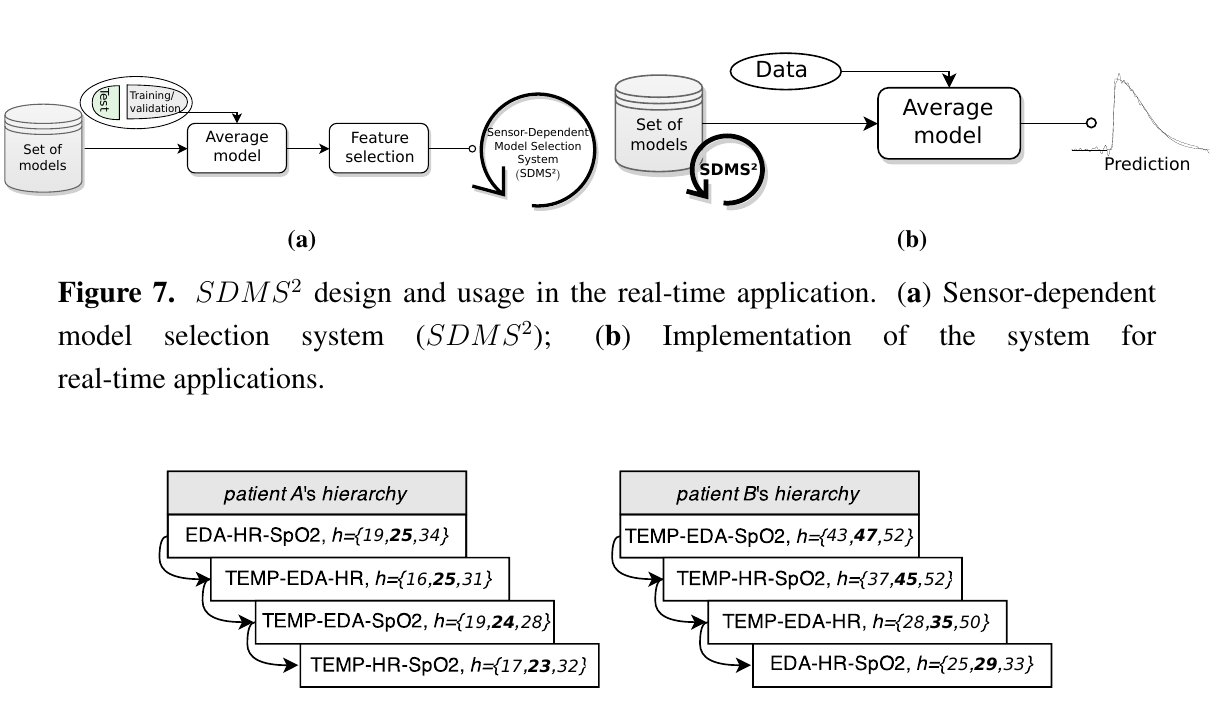
Figure 8. Hierarchies of sets of models for Patient A and Patient